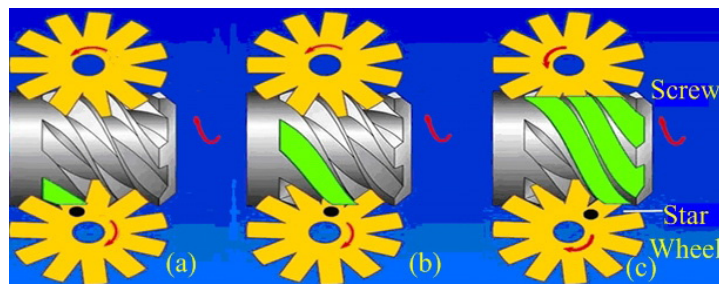
Figure 2. Configuration of CP type single screw expander.